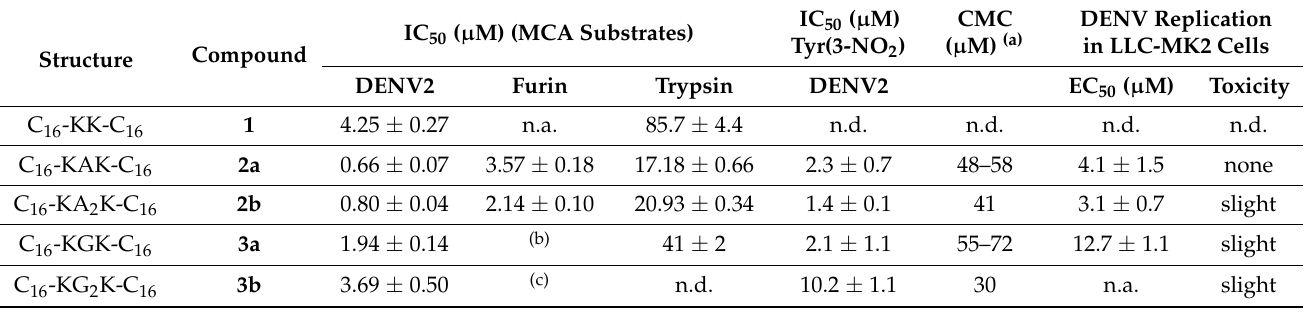
Table 1. Properties and activities (IC 50 , µ M) of the lysine geminoids 1–3 . Assay conditions, DENV2 protease (MCA): 50 mM Tris.HCl, pH 9.0, 20% glycerol, with 20 nM DENV2 protease and 20 mM Z- RR-MCA, 37 ◦ C; furin: 10 mM Mes. NaOH, pH 7.0, with 0.76 nM furin and 2.35 mM